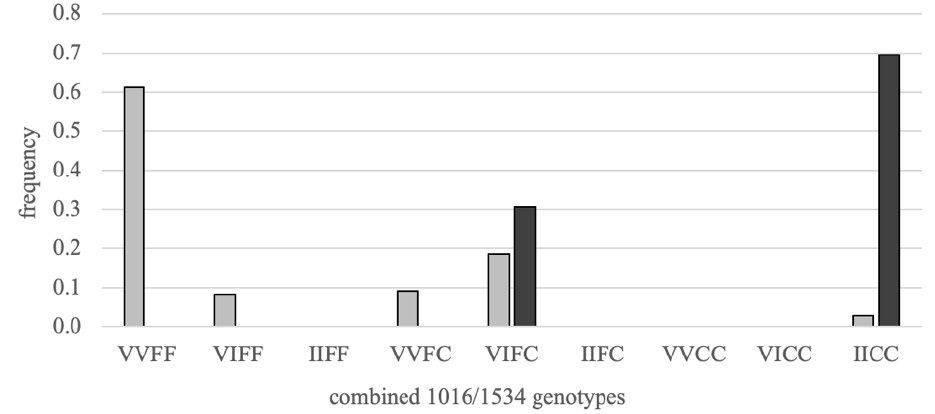
Figure 1. The frequency of 1016/1534 genotypes for both the susceptible and resistant strains used in the study. Randomly selected females from the susceptible (light bars) and resistant (dark bars) strains were genotyped for both V1016I and F1534C knockdown resistance (kdr) mutations. Double homozygote-susceptible individuals (VVFF) are on the far left and double homozygote-resistant (IICC) on the far right. Table 1. Observed and expected haplotype numbers in both strains, with the standardized disequilibrium value and test of significance of the linkage disequilibrium. Vs: Vergel-susceptible, Vr: Vergel-resistant. For haplotypes, the first letter represents the allele at the 1016 locus and the second letter represents the allele at the 1534 locus. Strain Haplotypes Observed N